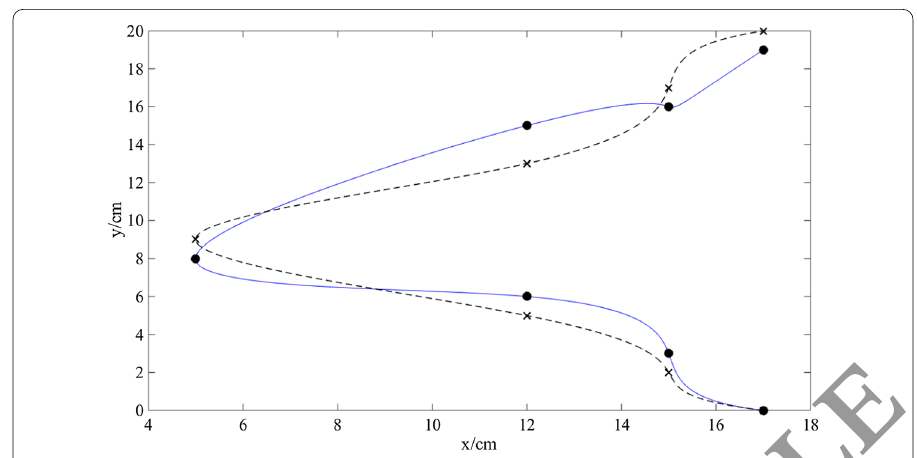
Fig. 3 Actual fitting curve of flexible